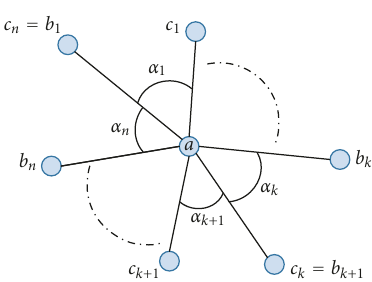
Figure 2: Gluing of triangles to make a surface of various curvatures depending on the sum of the α k